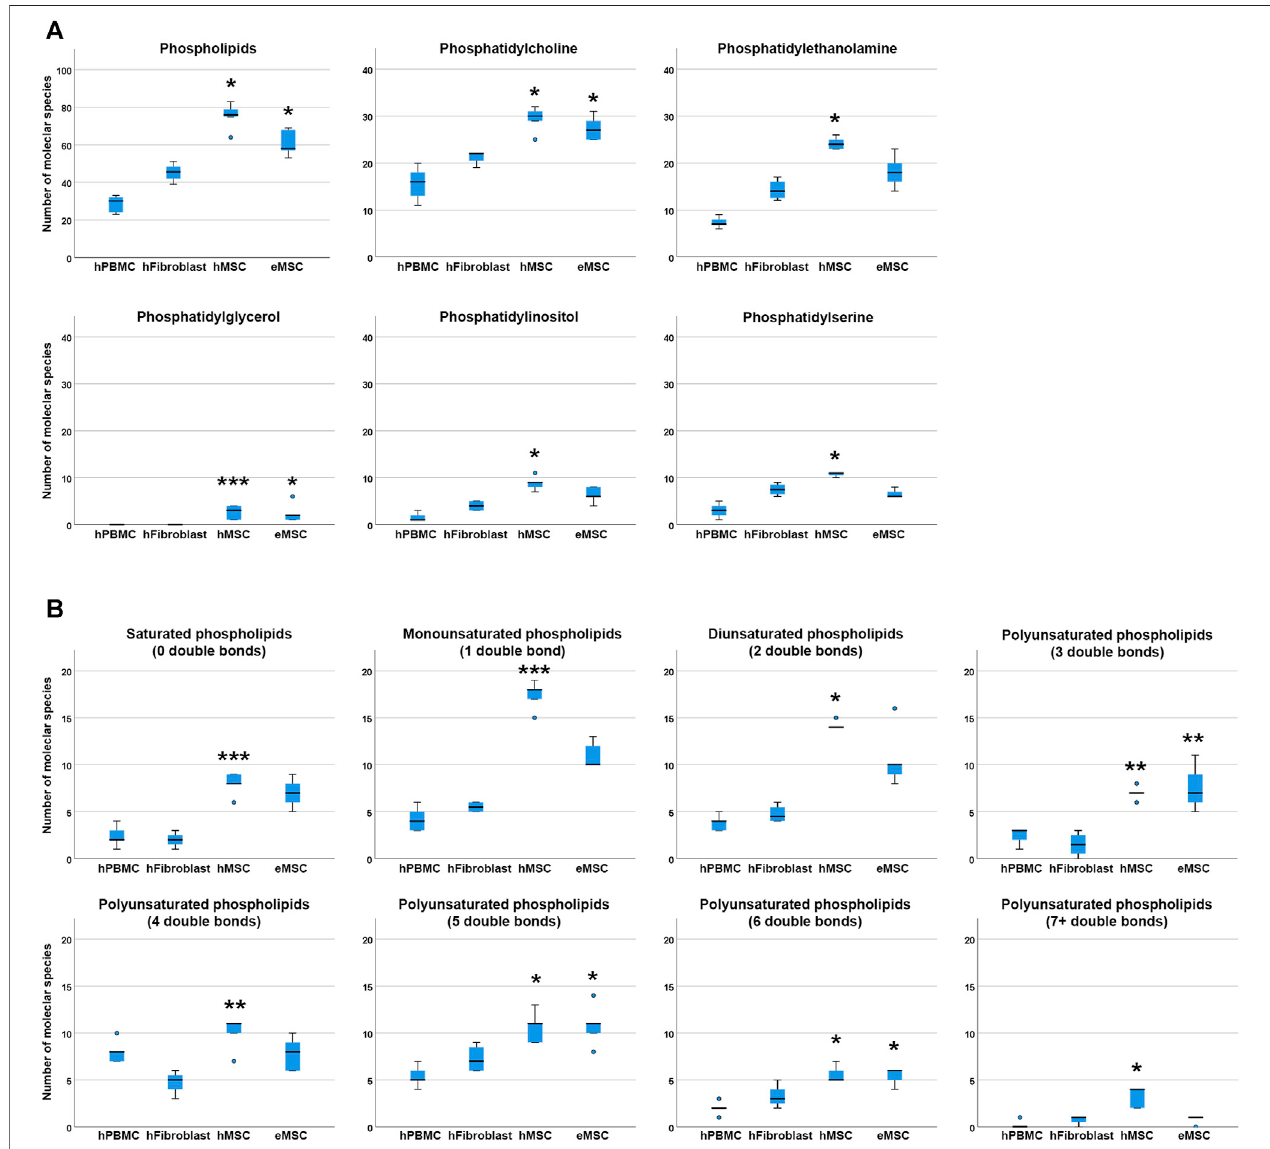
FIGURE 3 | Phospholipid species diversity in different mesodermal cell types. Panel A boxplots represent the numbers of either total phospholipid molecular species or the numbers of phospholipid species within the different phospholipid classes. Panel B boxplots represent the numbers of phospholipid molecular species within lipid groups by extent of saturation. Asterisks indicate signi fi cant differences between MSC and hPBMC (*), hFibroblasts (**) or both (***) ( p ≤ 0.050). Data were obtained from n (cid:1) 4 donors for hFibroblasts and n (cid:1) 5 donors for all other cell types.